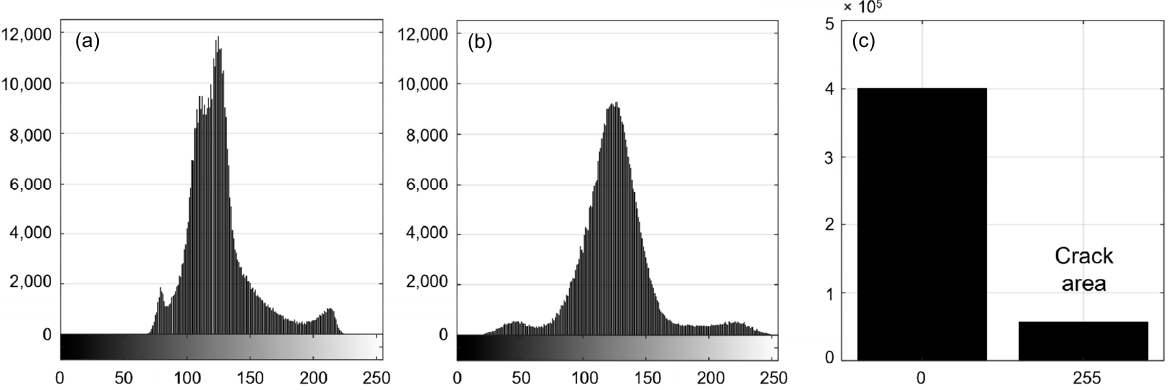
Figure 5. Image histogram analysis: ( a ) raw image, ( b ) contrast-limited adaptive histogram equalization (CLAHE) image, and ( c ) extraction image.